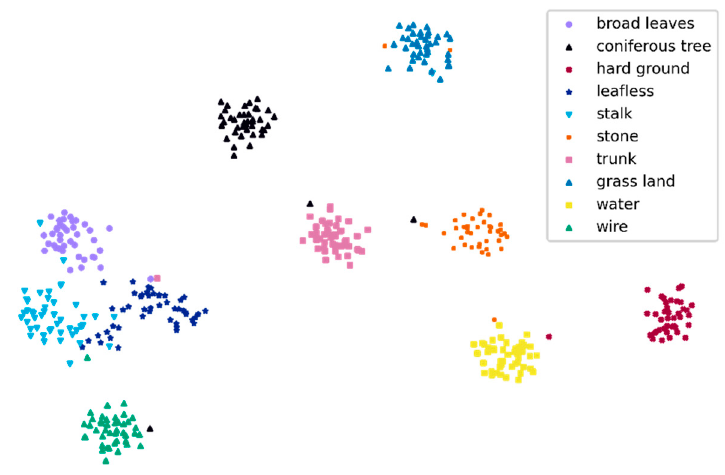
Figure 8. T-distributed stochastic neighbour embedding (T-SNE) [64] visualization of the last hidden layer representations produced by ResNet152 for ten habitat element classes (the coloured point clouds represent the different habitat element categories, showing how the algorithm clustered these categories). Most habitat elements were grouped independently according to their categories, but broad-leaved trees, leafless plants, and stalk were more concentrated, and wires were closer to these three categories.